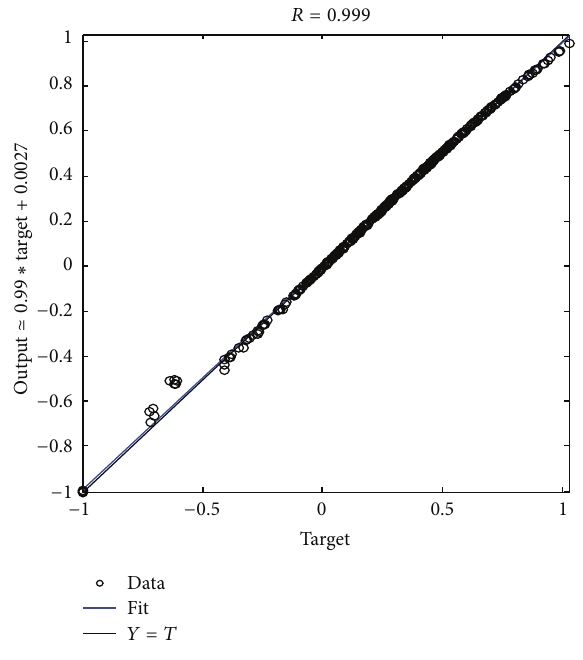
Figure 10: FFBP regression of error.